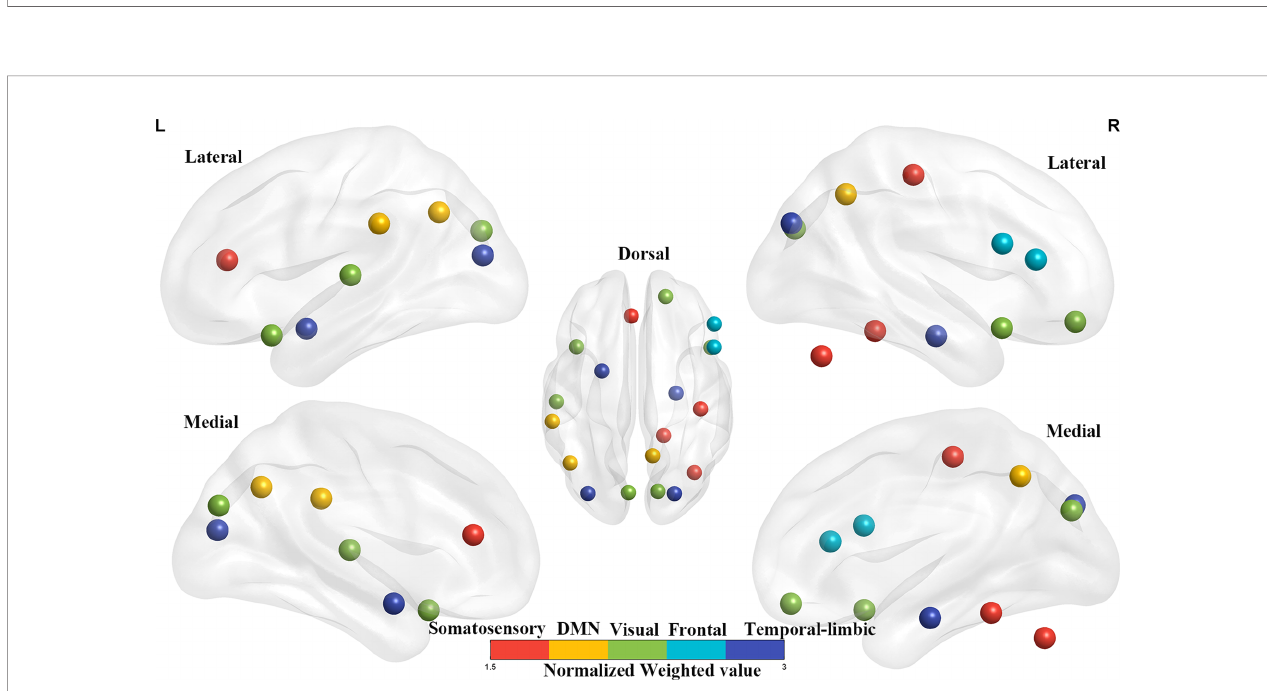
FIGURE 3 | The brain maps of pre-symptomatic RE and non-RE based on gFCD at the voxel level. RE, radiation encephalopathy; NPC, nasopharyngeal carcinoma; FCD, functional connectivity density.